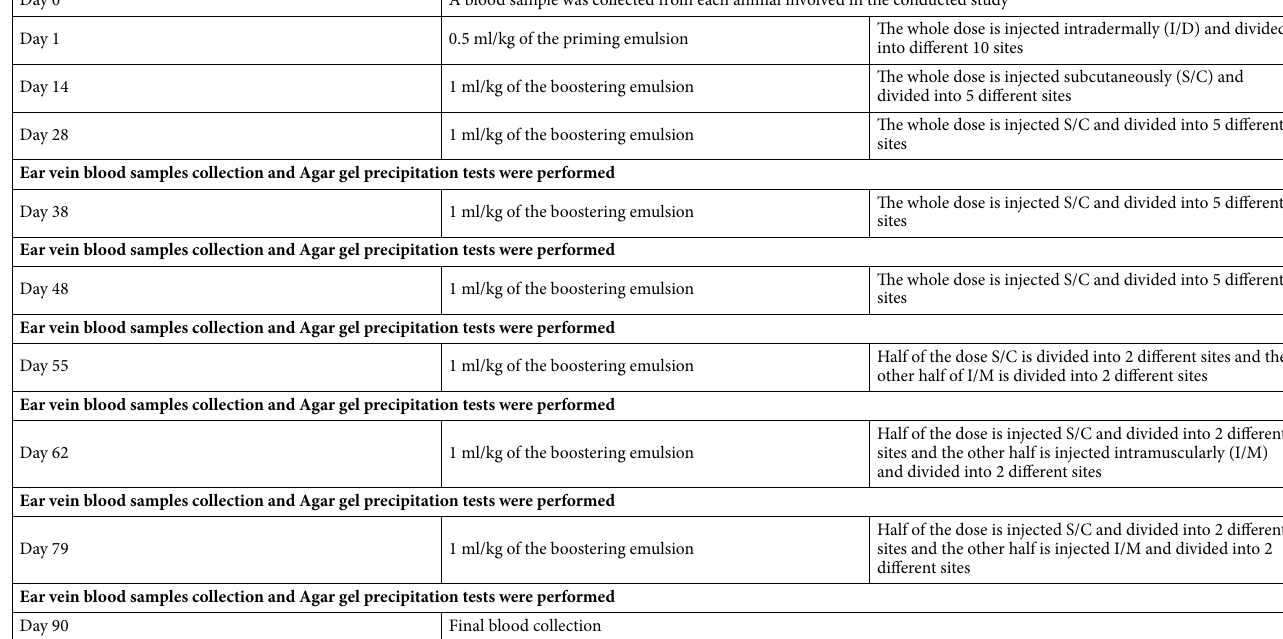
Table 5. Illustration of a detailed animal immunization